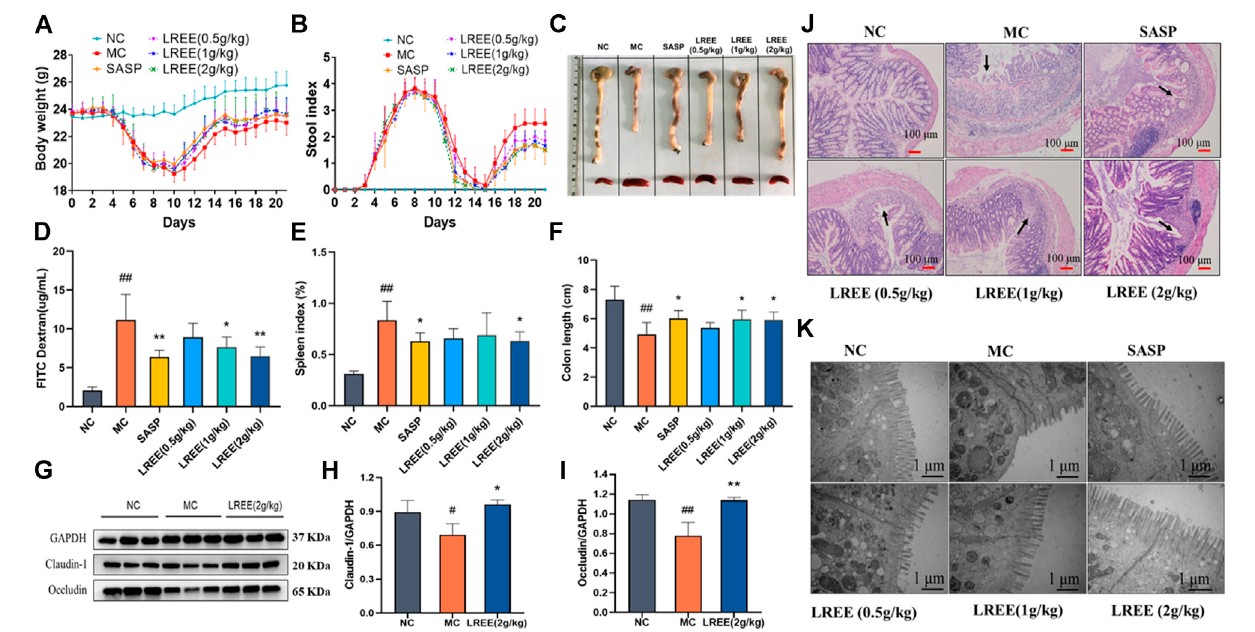
FIGURE 2 | LREE signi fi cantly attenuated disease symptoms and improve the histopathological changes of colon in ulcerative colitis model mice ( n (cid:2) 6). (A, B) Statistical analysis of body weight and stool index of mice. (C) The gross morphology and length of colon and the size of spleen of mice. (D) The data of intestinal permeabilityofmice. (E) Statisticalanalysisofspleenindexofmice. (F) Statisticalanalysisofthelengthofcolonofmice. (G) WBanalysisoftightjunctionproteinsclaudin- 1 and occludin in the colon of mice. (H, I) Densitometry analysis of claudin-1 and occludin levels. (J) Representative microscopic images of H&E-stained colon sections (100X). (K) Representative ultrastructural images observed by transmission electron microscope (50,000X). # P ＜ 0.05, ## P ＜ 0.01 vs. NC group. * P ＜ 0.05, ** P ＜ 0.01 vs. MC